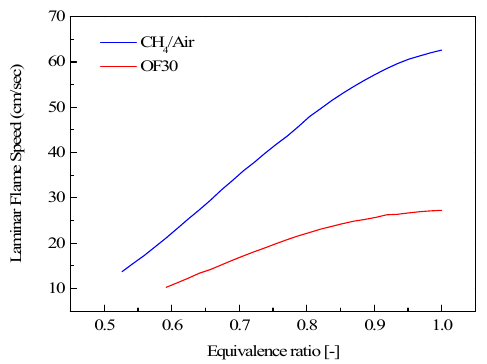
Figure 7. Laminar flame speed of CH 4 /air and OF30 flames as a function of equivalence ratio at a preheating temperature of 396.15 K.